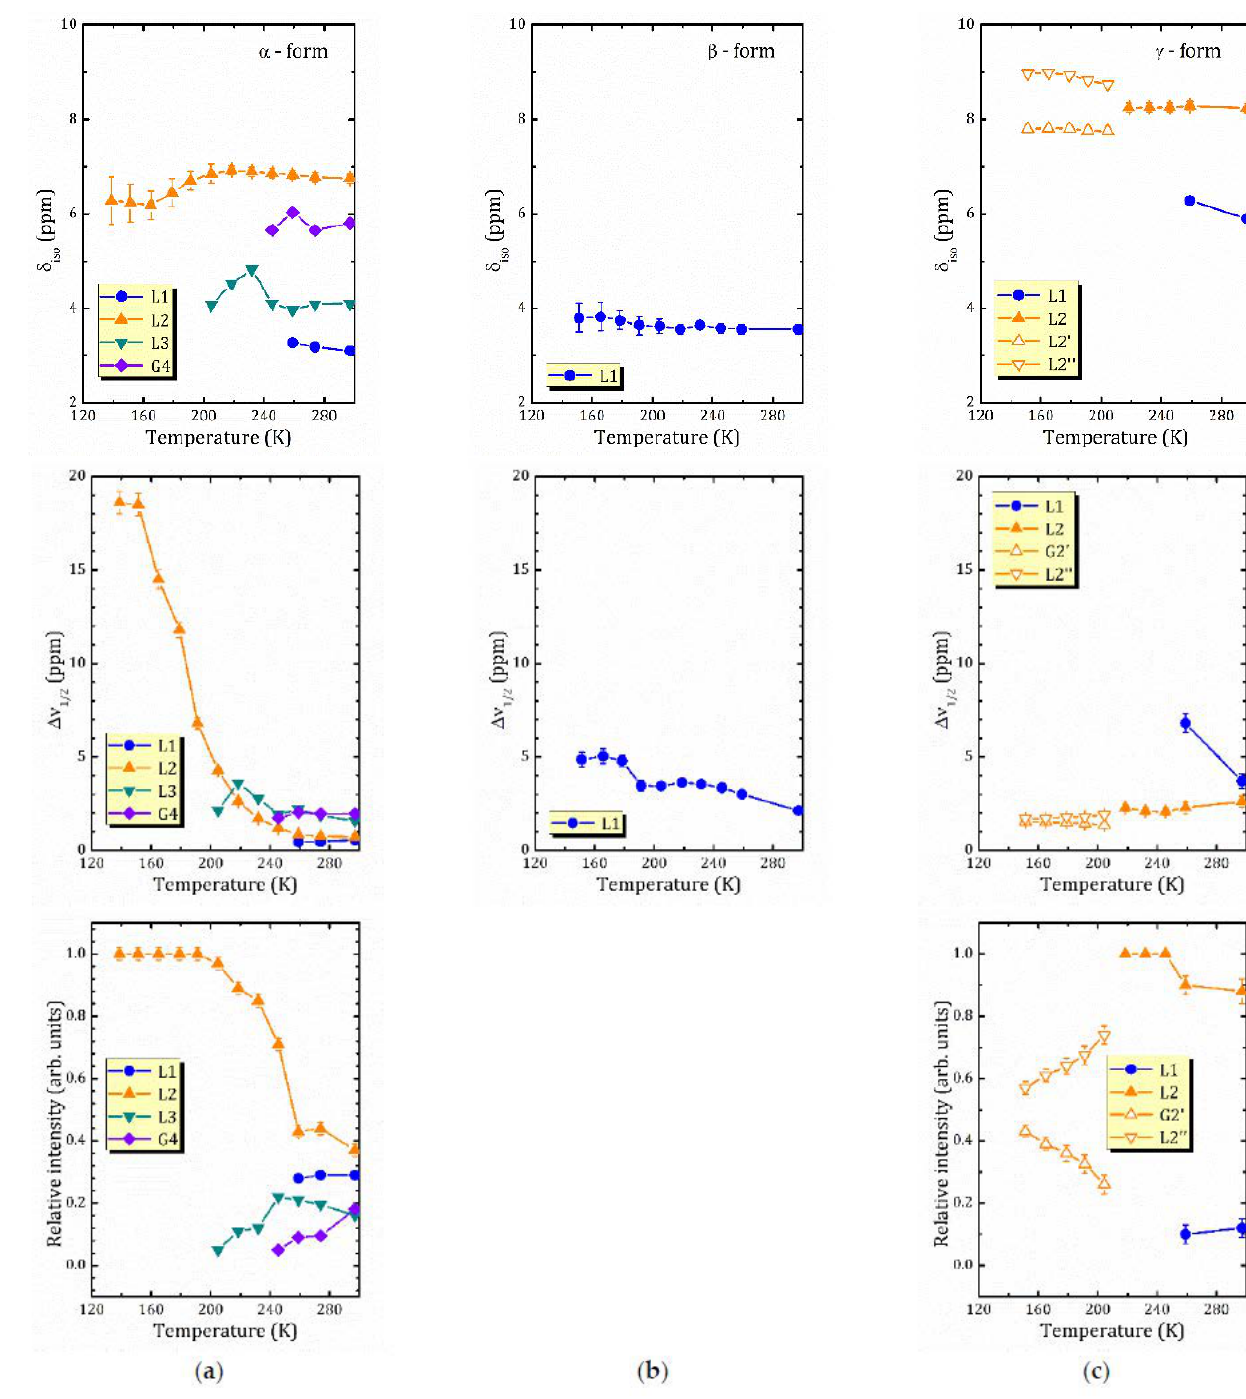
Figure 6. Temperature dependencies of the 1 H isotropic chemical shift (the upper row), the line width at half maximum (the middle row), and the integral intensities (the bottom row) for the α - ( a ), β - ( b ), and γ - ( c ) forms of HCa 2 Nb 3 O 10 · y H 2